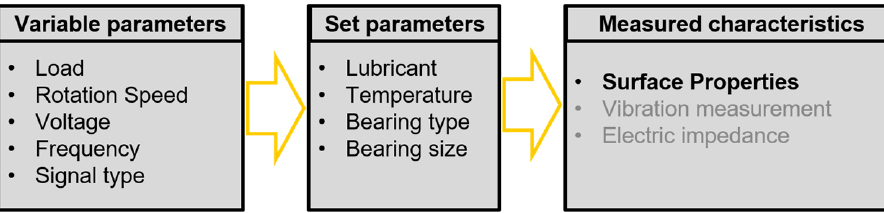
Figure 3. Design of the experiment. Each test sequence is grouped in five different phases, as shown in Figure 4. The first phase is a run-in of the bearings for six hours under an axial load F Ax = 3500 N and a rotation speed n = 2500 rpm. The aim is to reduce surface peaks and obtain comparable starting conditions for the damaging phase. It is followed by three electric damaging phases of three hours each with disassembly and a surface evaluation at the end of each phase. The fifth and last phase is an electric damaging period of 12 hours. The operating conditions at each of the damaging phases are constant and given for all tests in Table A1.